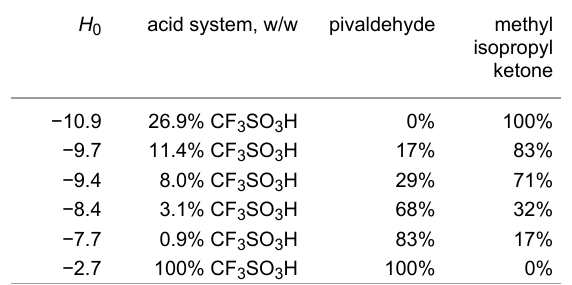
Table 2: Isomerization of pivaldehyde in CF 3 SO 3 H:CF 3 CO 2 H solu- tions a